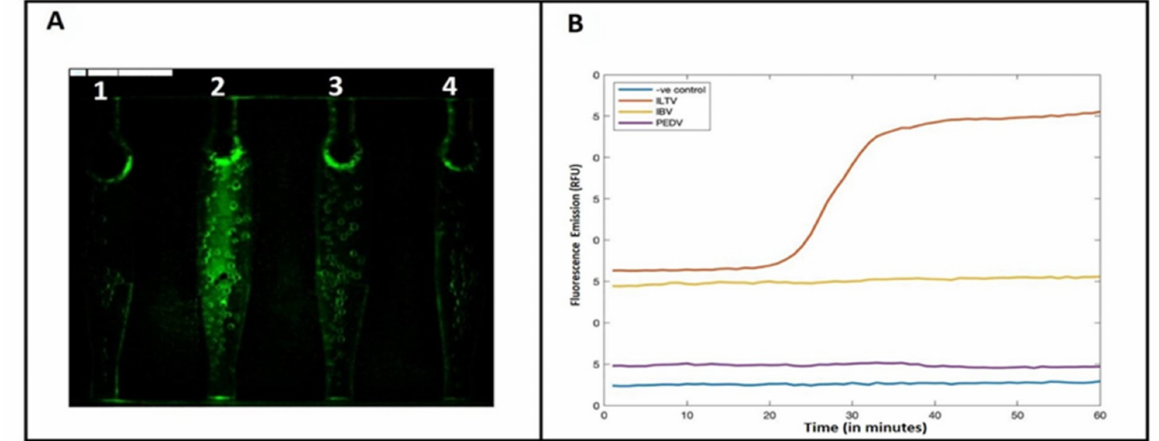
Figure 4. ( A ) Fluorescence emission image at the end of the LAMP amplification process in the microfluidic chip (1: negative control; 2: ILTV positive sample; 3: IBV positive sample, 4: PEDV positive sample). ( B ) Reaction cham- bers average fluorescence intensities as functions of time, showing positive amplification of the ILTV sample only.